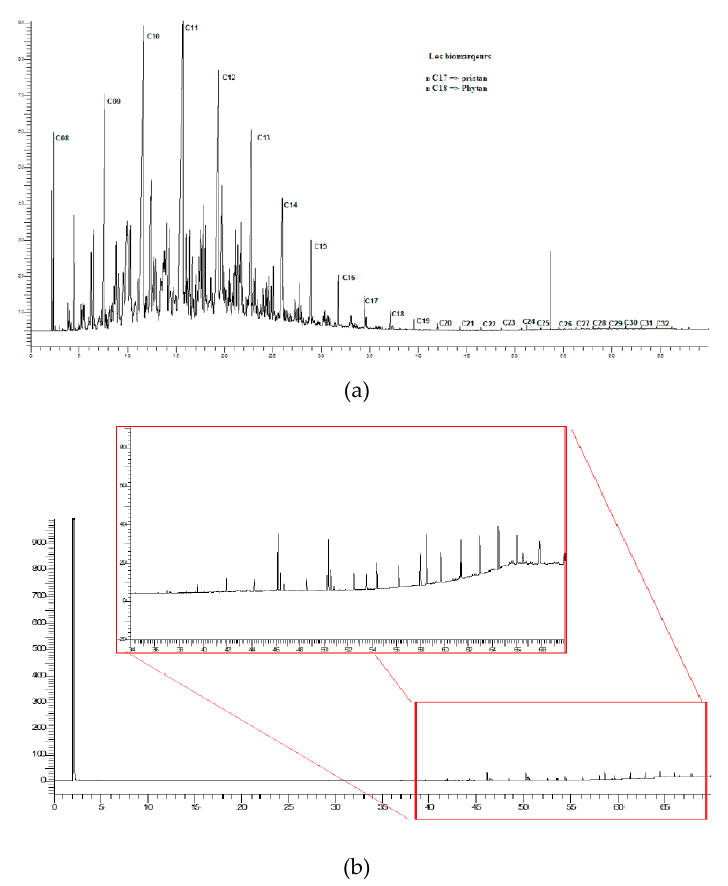
Figure 5. Chromatogram corresponding to the sample before ( a ) and after ( b ) the photocatalytic degradation in seven hours of sunlight irradiation.